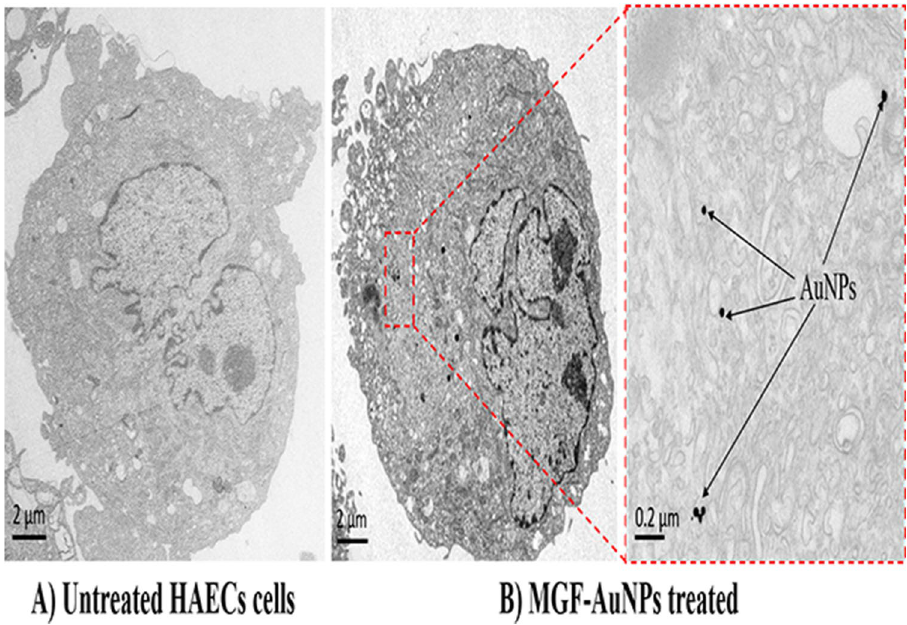
Figure 4. TEM images showing minimal uptake of MGF-AuNPs into human aortic endothelial cells (HAECs), 60 min post treatment of MGF-AuNPs (41 µM). ( A ) HAECs cells control; no treatment; ( B ) MGF-AuNPs treated cells (41 µM).